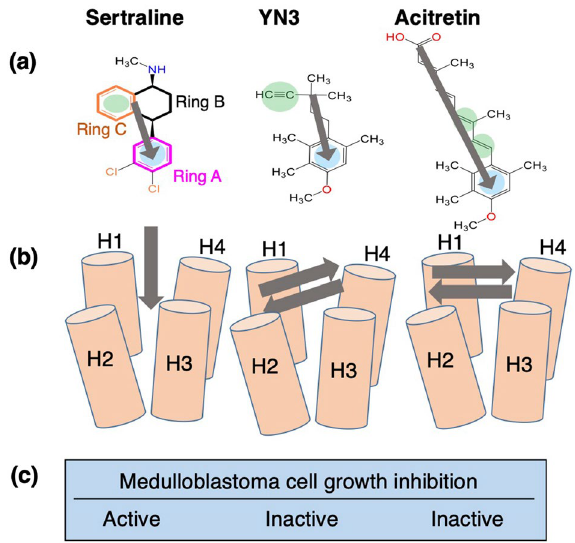
Figure 8. ( a ) Chemical structures of three compounds, and their orientations (gray arrows). Rings A, B and C of sertraline are depicted in magenta, black, and orange, respectively. Blue circles represent aromatic rings that are expected to interact with the hydrophobic cleft of mSin3B from conventional structure–activity relationship (SAR). Green circles represent π -electron rich regions. ( b ) Orientations of the compounds in the bound forms with mSin3B, resulted from the present MD simulation study. ( c ) Presence/absence of medulloblastoma cell- growth inhibition activities for the